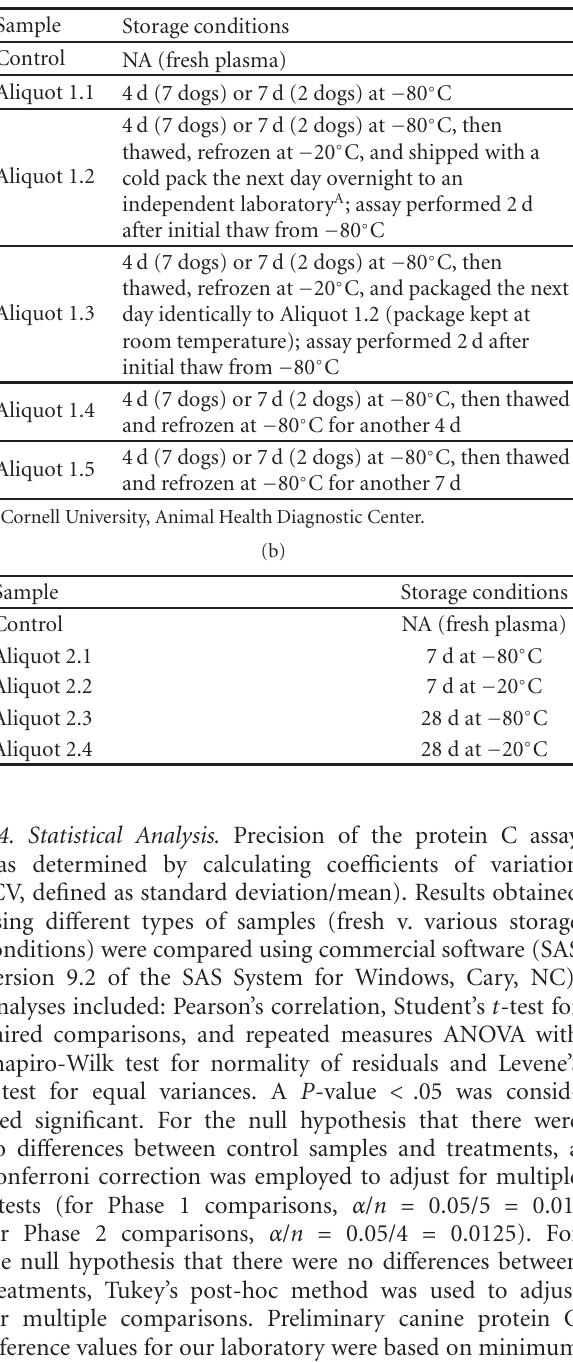
bu ff er, 3 readings were 0.000 and 1 was 0.001. Based on 6 assay run, the CV was 1.4%. Standard curves generated